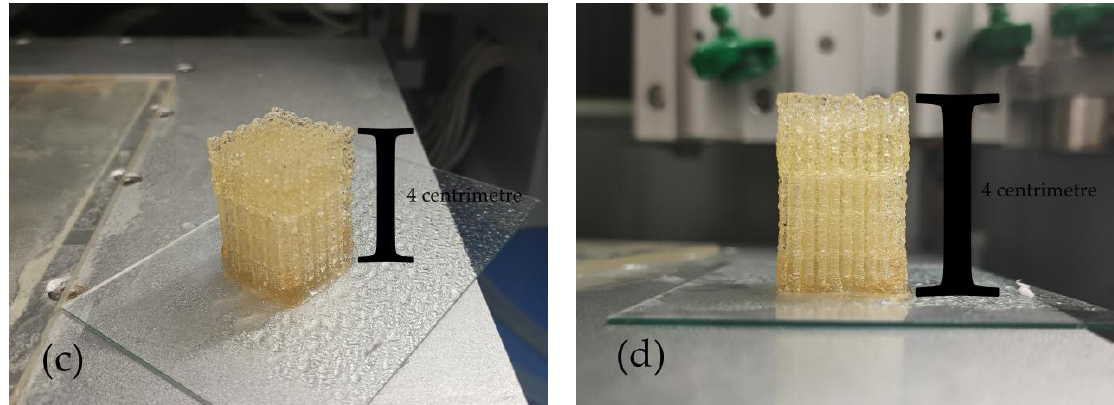
Figure 5. The 3D-printed structures of gelatin/alginate/agarose hydrogel at 10 °C. ( a ) Twenty-layer structure. ( b ) Eighty- layer structure. ( c ) The side top view of one-hundred-and-thirteen-layer structure. ( d ) The front view of one-hundred-and- thirteen-layer structure.